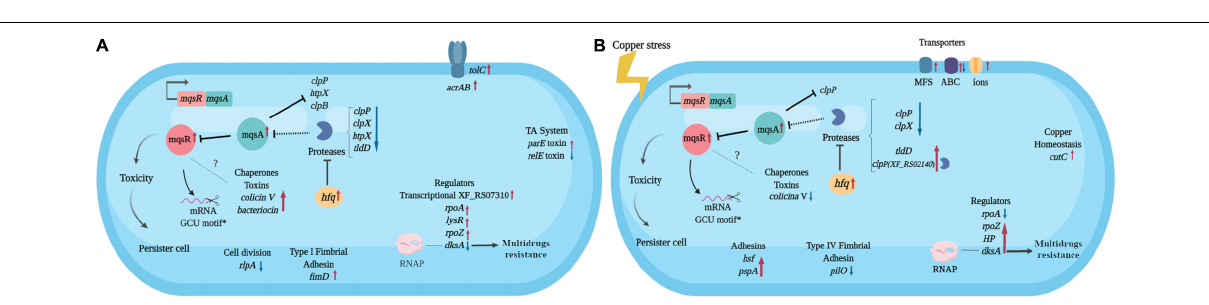
FIGURE 6 | Hypothetical model of the X. fastidiosa MqsR-dependent regulon. Response to overexpression of mqsR in X. fastidiosa (A) and under copper stress (B) . Arrows pointing to the side ( → ) indicate direct regulation and up ( ↑ ) red arrows indicate upregulation, while ⊥ indicates inhibition and down ( ↓ ) blue arrows indicate downregulation. Dashes indicate direct binding and dotted lines indicate hypothetical regulations. *Demonstrated by Lee et al. (2014). The figure was created in